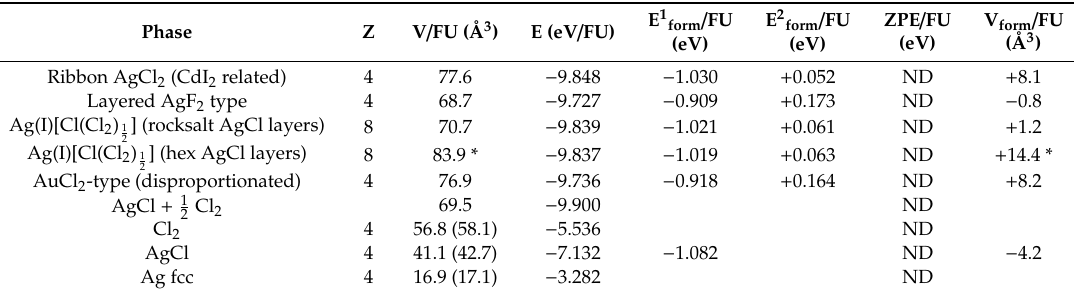
Table 2. Calculated HSE06 volumes and energies and formation energies calculated with respect to the elemental crystals (E 1 form = E − E Ag + Cl2 ) as well as to AgCl and 1 Cl 2 (E 2 form = E − E ) for five AgCl + 1 2 Cl2 2 prototypical AgCl 2 polymorphs. The formation energies are calculated considering high-temperature crystal structure of Cl 2 [43]. Volume values in brackets come from experiment. The formation energy for AgCl is calculated as E form = E − E Ag + 1 2 Cl2